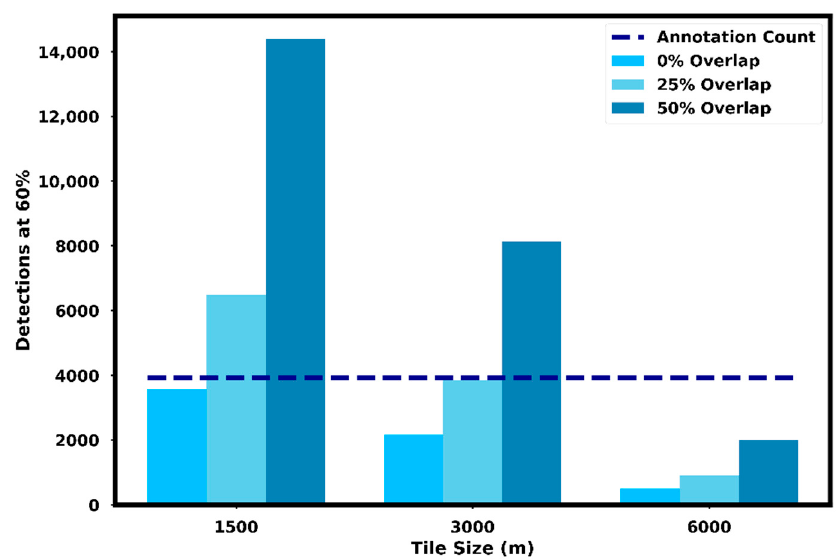
Figure 11. Delaware’s Carolina Bay detection counts at 60% threshold for various DEM tile sizes and overlap amounts compared to the annotation count.